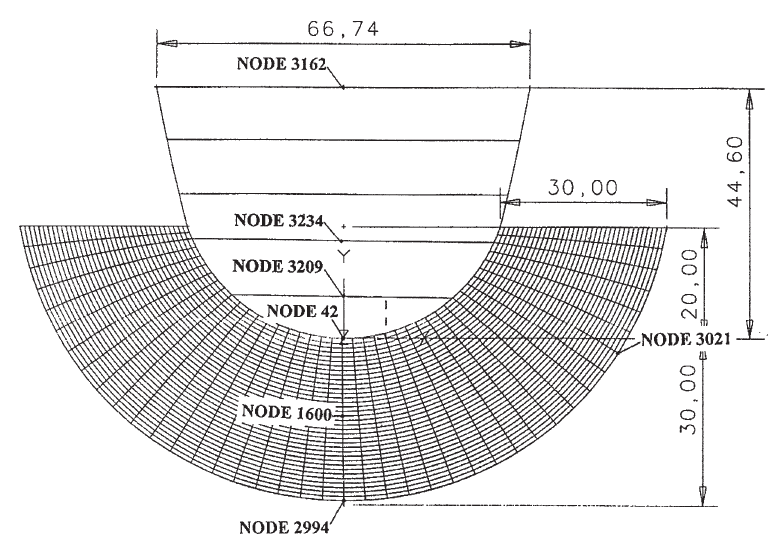
Fig. 7. Two-dimensional ship structure and fluid model.